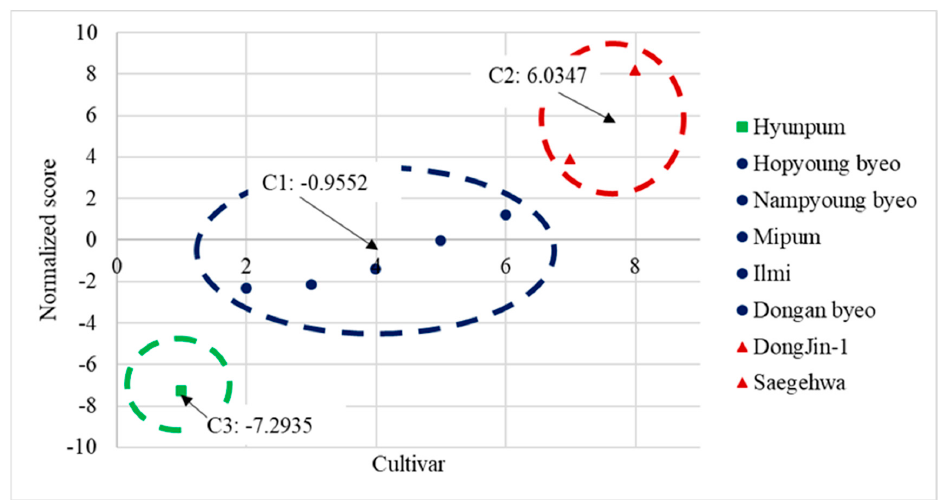
Figure 4. Visualization of k ‐ means clustering based on normalization scores (C1: cultivar group 1, C2: cultivar group 2, and C3: cultivar group 3). Morphological characteristics and yield for all three clusters are summarized in Ta ‐ bles 6 and 7, respectively. Group 1 took the longest time to flower among the clusters. Group 2 had the largest number of spikelets per panicle (110.26), spikelets per m 2 (39.26 × 10 3 ), and filled spikelets per m 2 (35.83 × 10 3 ). Group 3 had the tallest plant (77.54 cm) among the groups but the shortest length of inflorescence (19.82 cm). Table 6. Number of days from transplantation date to flowering date, number of panicles per m 2 , number of spikelets per panicle, number of spikelets per m 2 , number of filled spikelets per m 2 , height, and length of panicle for each cluster.